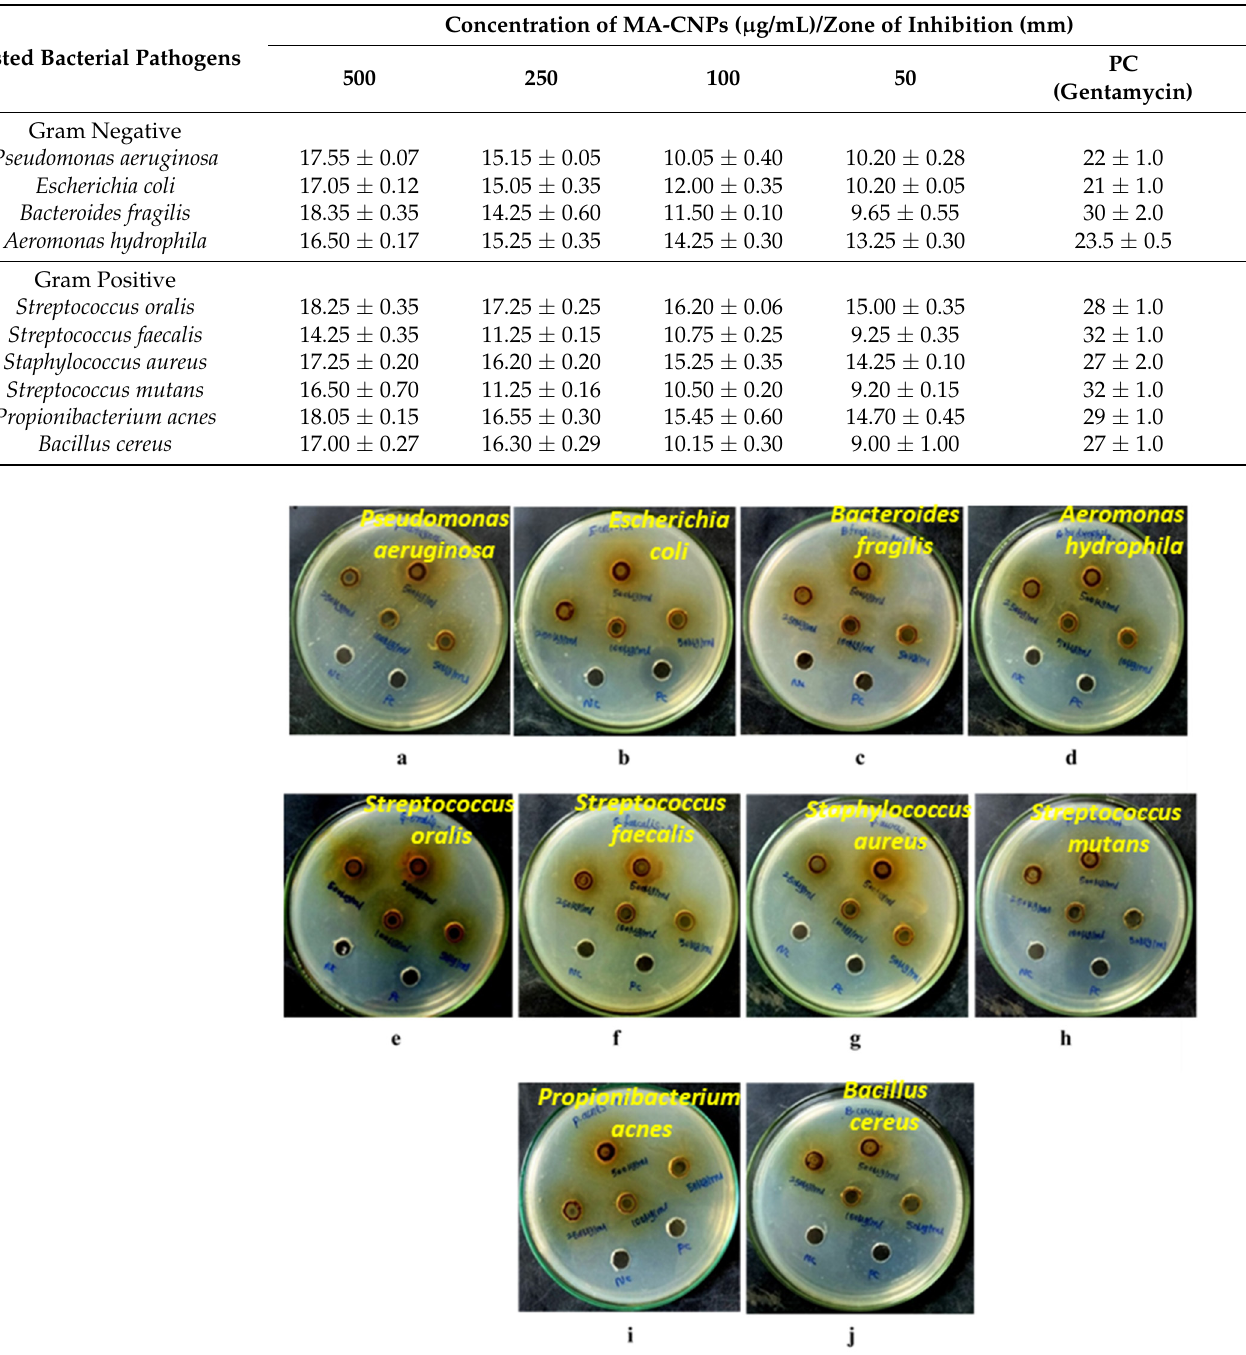
Figure 7. Antimicrobial activity of MA-CNPs (( a ) Pseudomonas aeruginosa , ( b ) E. coli , ( c ) Bacteroides fragilis , ( d ) Aeromonas hydrophila , ( e ) Streptococcus oralis , ( f ) Streptococcus faecalis , ( g ) Staphylococcus aureus , ( h ) Streptococcus mutans , ( i ) Propionibacterium acnes , ( j ) Bacillus cereus ).